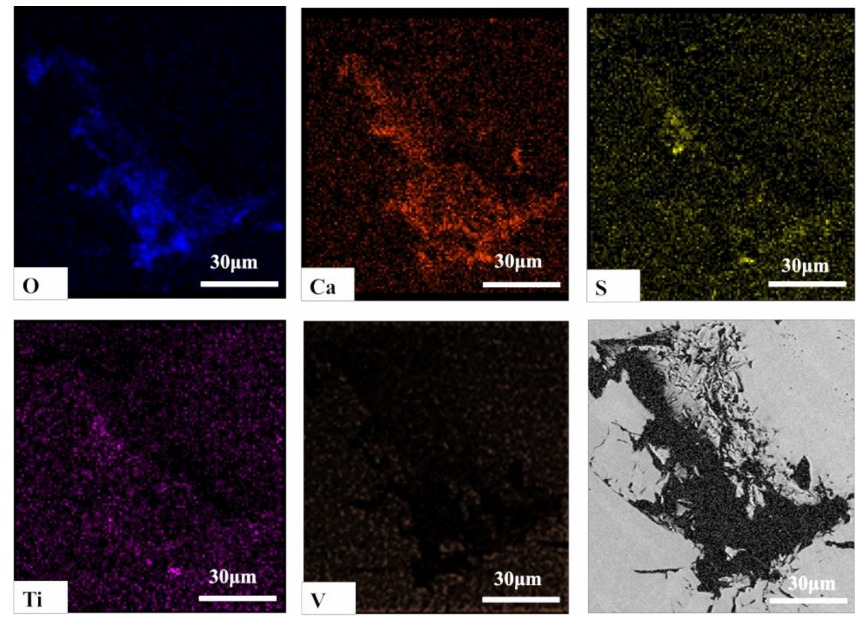
Figure 6. Agglomerate of CaO surrounded by TiO 2 and CaS.